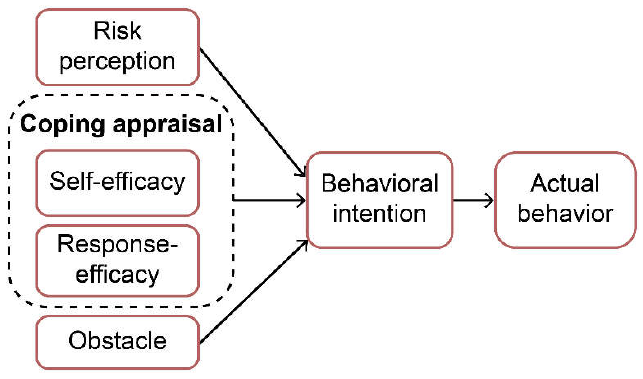
Figure 1. Behavioral intention factors affecting actual disaster preparedness behavior (Modified from the Protection Motivation Theory